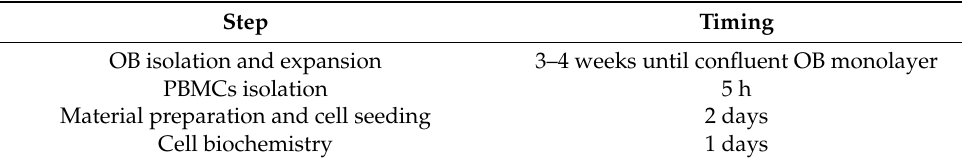
Table 1. Timing of the main steps of the protocol: osteoblasts (OBs) isolation from bone fragments and expansion, PBMCs isolation from buffy coat, material preparation, and cell seeding onto the material, cell biochemistry to evaluate cell behavior.